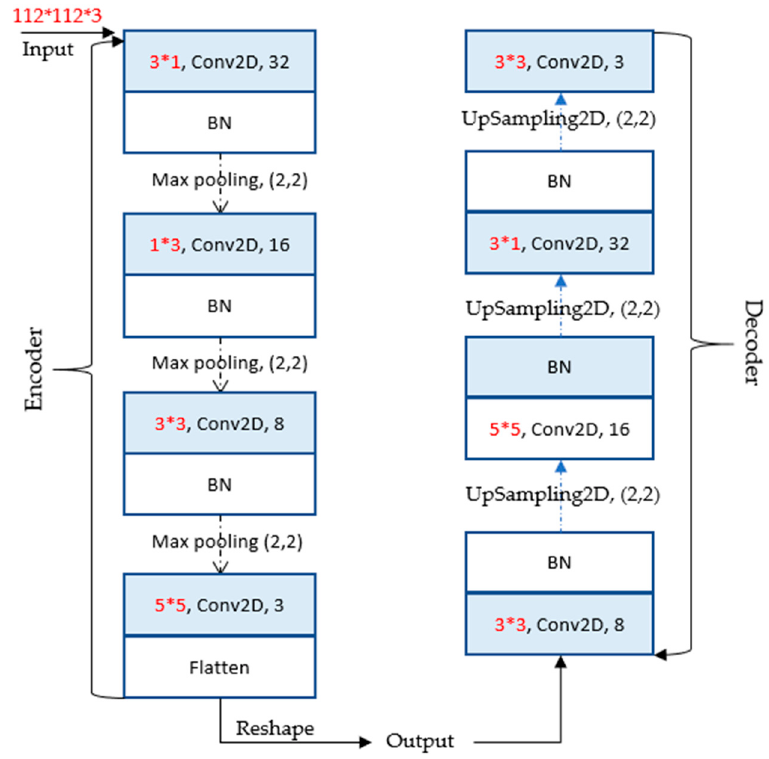
Figure 8. The network of the autoencoder.